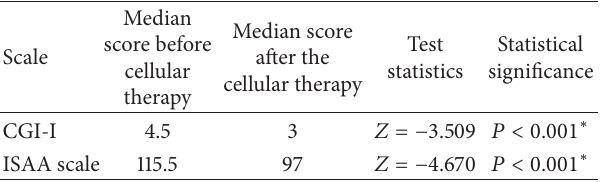
Table 2: Change in the scores of CGI and ISAA before and after